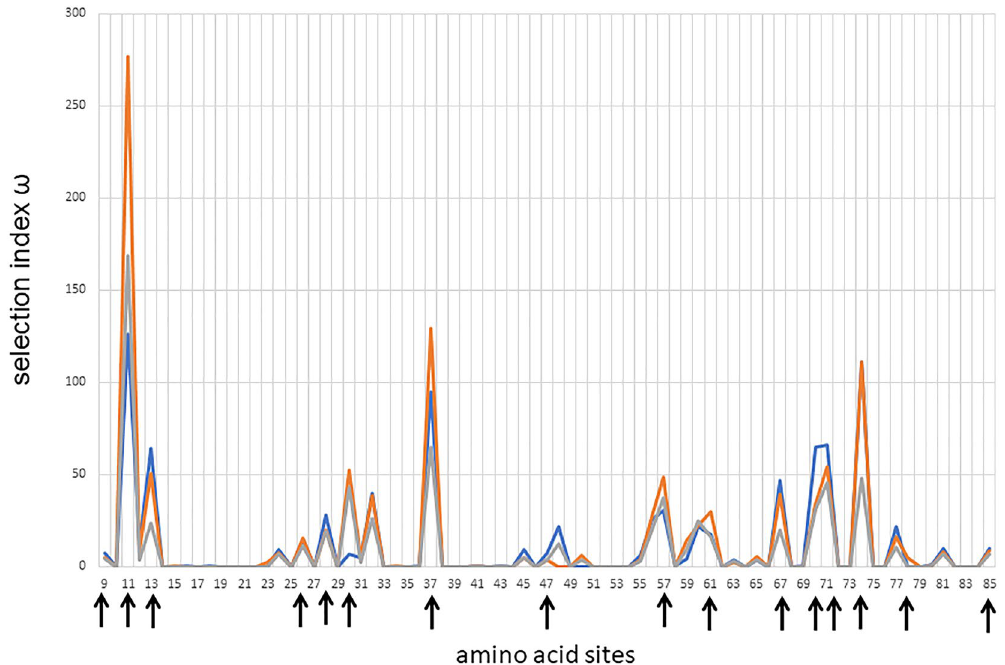
Figure 4. Estimated values of the selection index ω in each amino acid site along BoLA-DRB3 exon 2 in Baggara (grey), Kenana (blue) and Butana (brown) Sudan cattle breeds. Arrows indicate the antigen-binding site